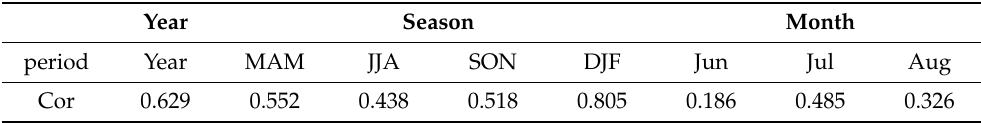
Figure 7. Difference between afternoon precipitation in ( a ) annual average, ( b ) June-July-August (JJA) average, ( c ) March-April-May (MAM) average, ( d ) June average, ( e ) September-October-November (SON) average, ( f ) July average, ( g ) December-January-Februrary (DJF) average, and ( h ) August average from 2010 to 2019 and from 2001 to 2010 (mm/month). Table 1. Spatial correlation coefficients (Cor) between afternoon precipitation differences and total precipitation differences among the two decades in different